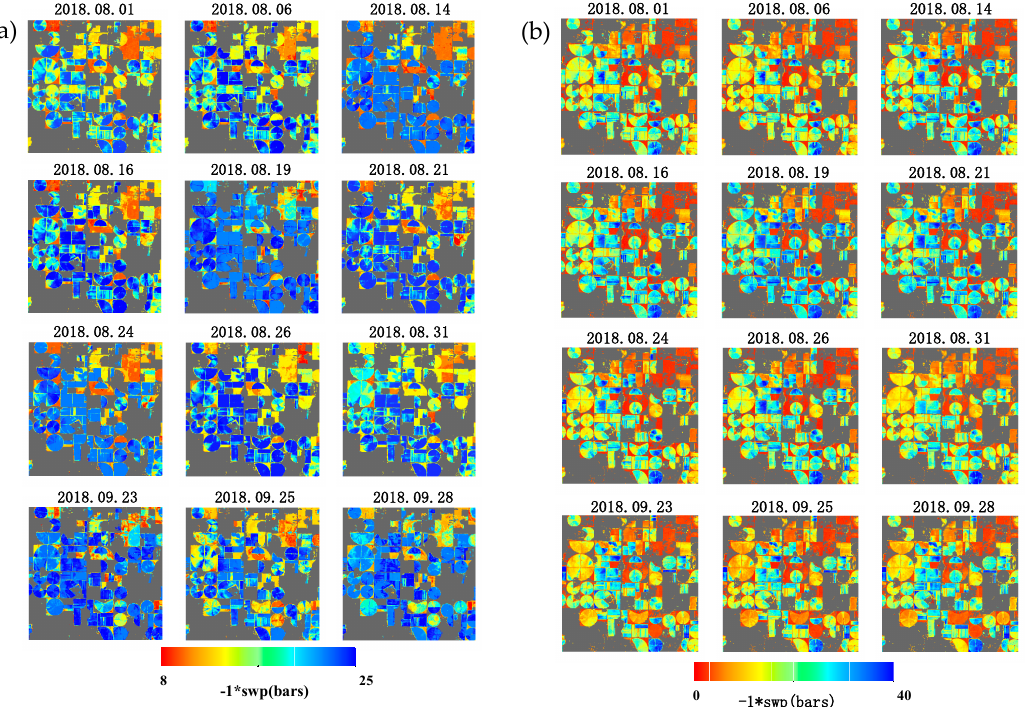
Figure 8. Continuous monitoring of stem water potential based on ( a ) random forest regression method and ( b ) linear regression method. The 2018 Crop Data Layer (CDL) was employed to mask out non-cotton areas (grey color).